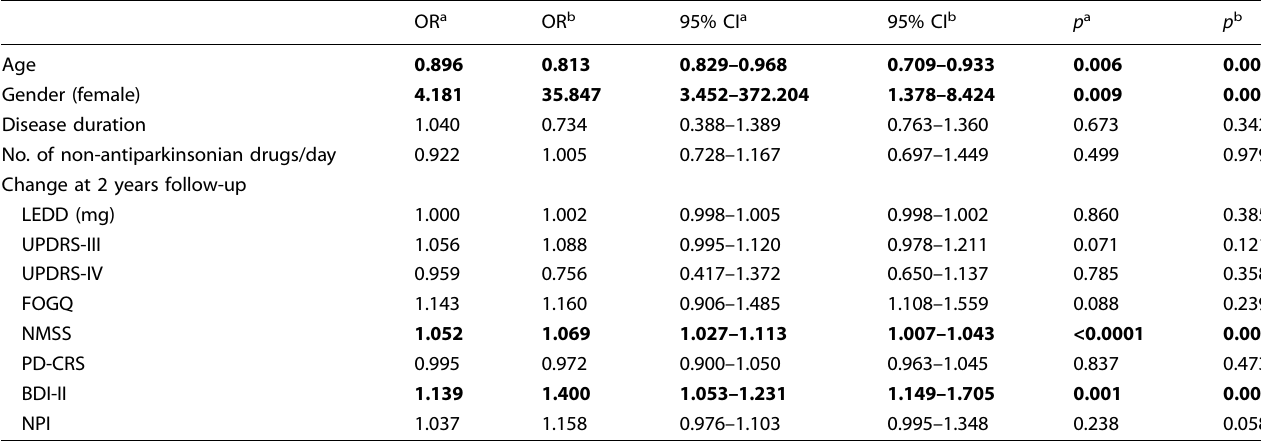
Table 3. Binary logistic regression model about factors associated with clinically signi fi cant HRQoL impairment at V2 (2 years